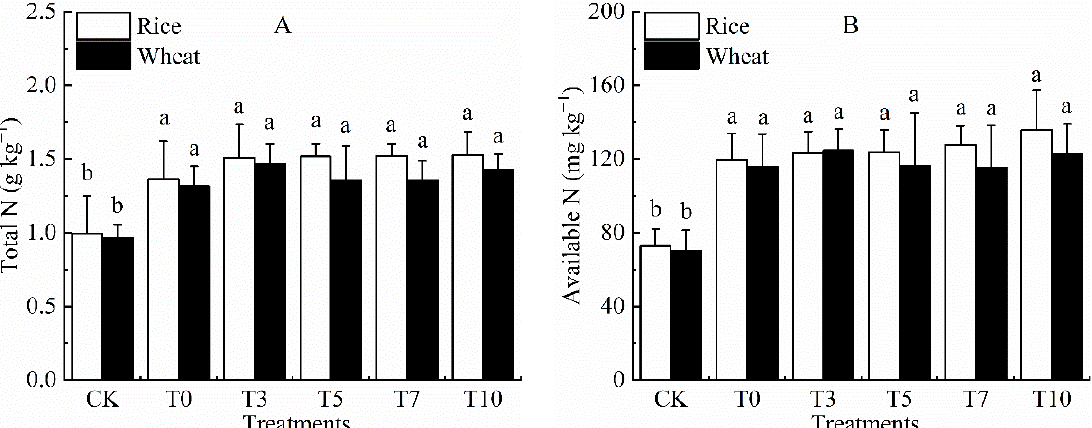
Figure 5. Effect of different fertilization treatments on the content of total nitrogen ( A ) and available nitrogen ( B ) in soil. Columns with different small case letters show significant difference between different treatments at p < 0.05 by LSD’s multiple range test. Values are mean of four replicates and bars show standard deviation. CK, no nitrogen fertilizer applied; T0, 100% conventional urea (CU); T3, one-time basal application of slow-release urea (SRU) and CU mixture with 30% SRU; T5, one-time basal application of SRU and CU mixture with 50% SRU; T7, one-time basal application of SRU and CU mixture with 70% SRU; T10, one-time basal application of 100% SRU.